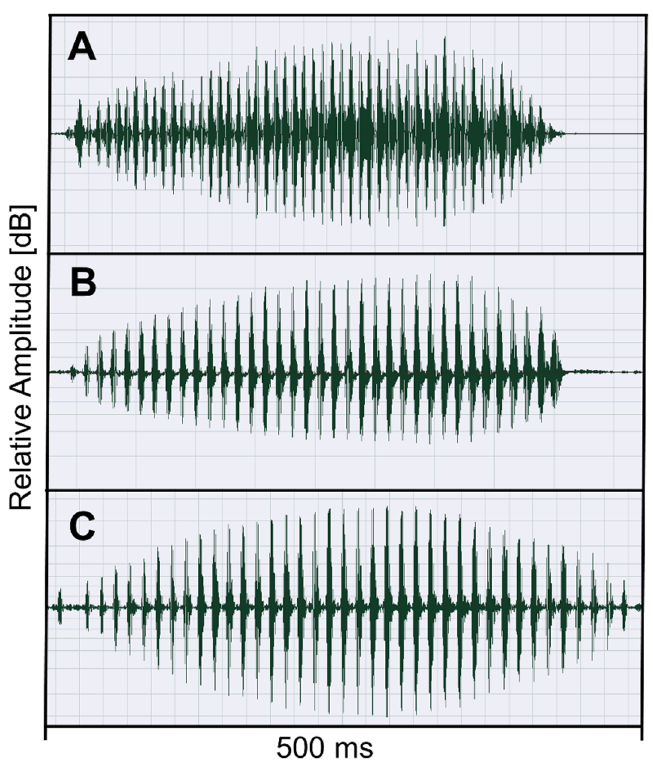
Figure 3. Representative oscillograms of advertisement calls given by males of ( A ) diploid O. cordobae , ( B ) tetraploid O. americanus , and ( C ) triploid specimens. Recording details: ( A ) 15 March, 2021, La Escondida, temperatures 20.6 °C (water), 18.4 °C (soil); ( B ) 5 February 2020, La Escondida, temperatures 19.1 °C (water), 23.0 °C (soil); ( C ) 5 February, 2020, La Escondida, temperatures 18.1 °C (water), 22.7 °C (soil).